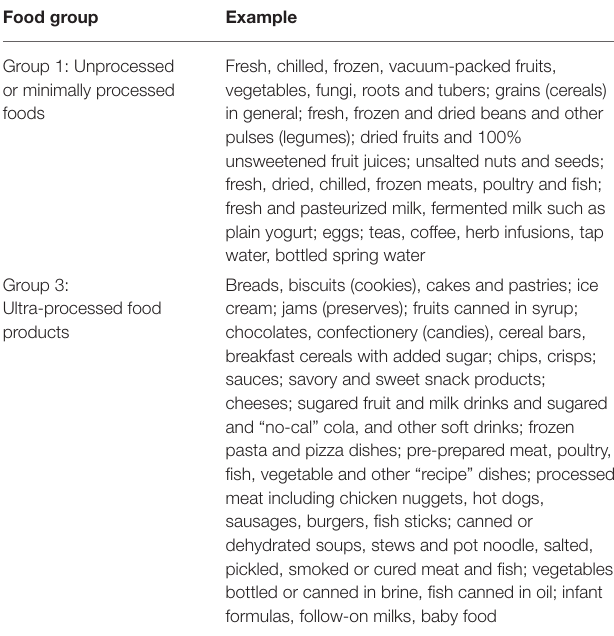
TABLE 2 | Food products as stand-in examples for selected industrial processing [after ( 44)]. Food